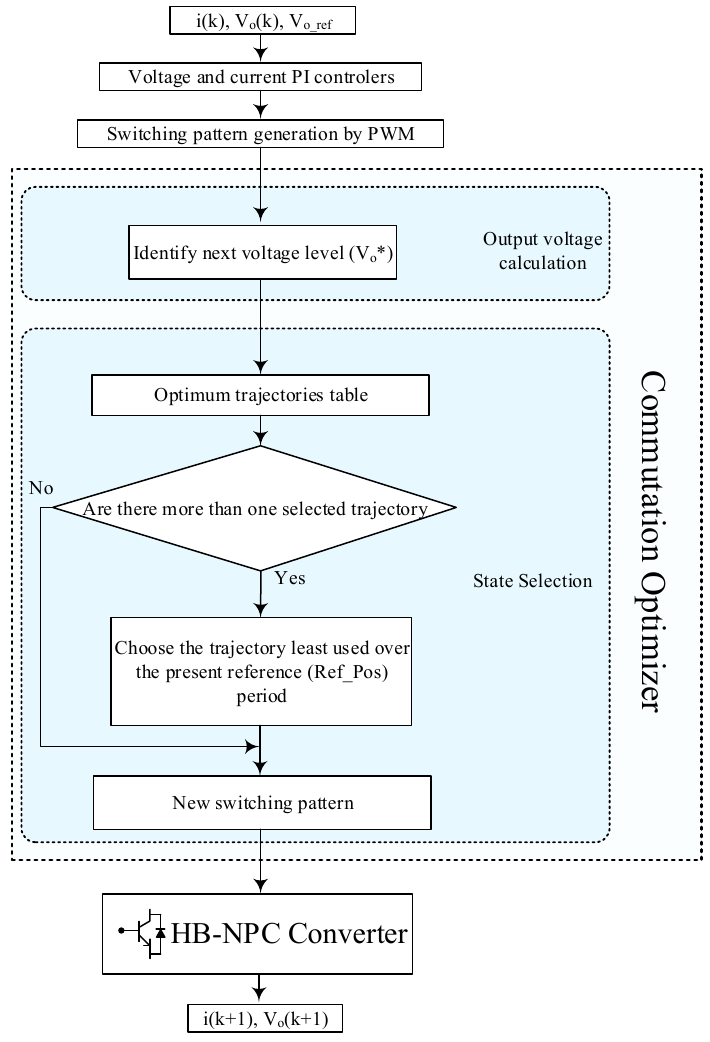
Figure 13. The final algorithm for OPTimized